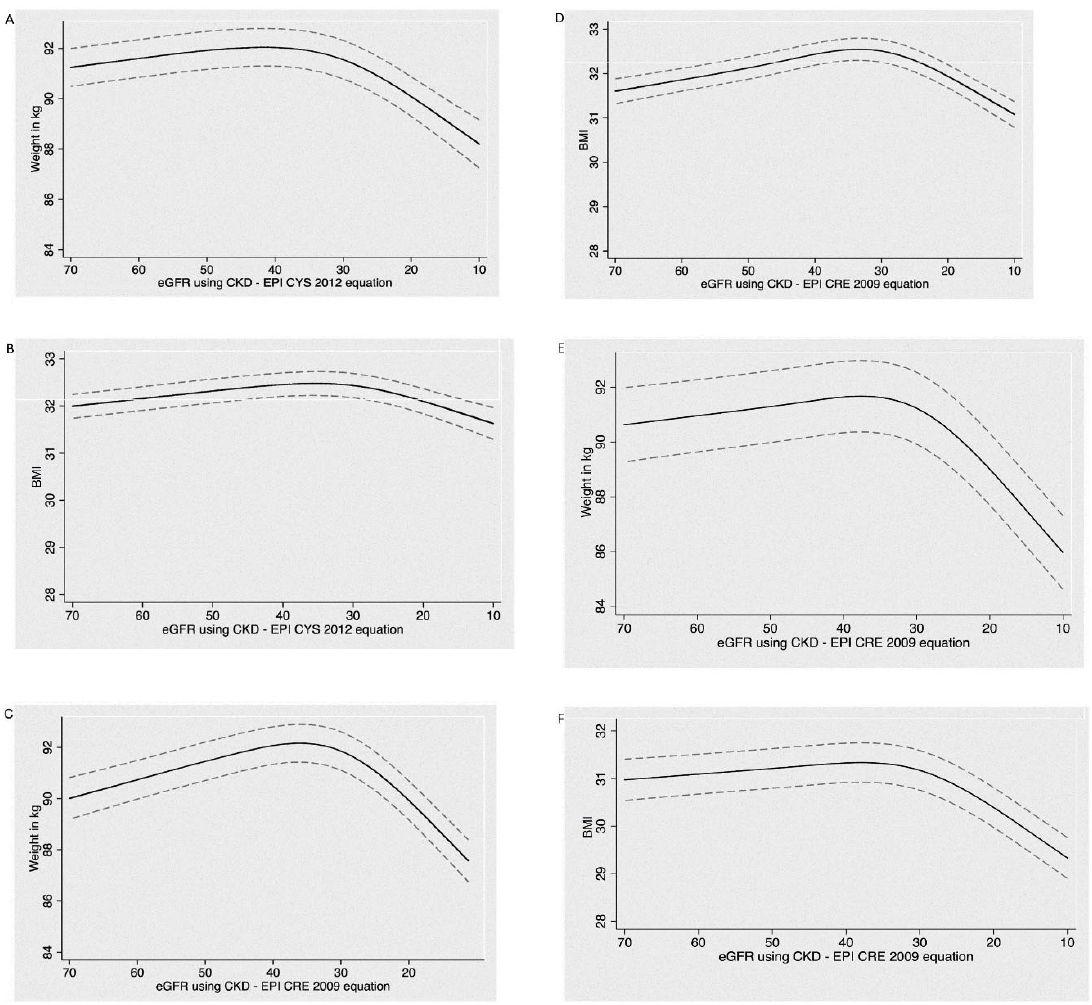
Figure 2. Repeated measures of weight and body mass index with advancing CKD. ( A ) Longitudinal repeated measures of weight with repeated measures of eGFR by cystatin C in CRIC. ( B ) Longitudinal repeated measures of BMI with repeated measures of eGFR by cystatin C in CRIC. ( C ) Longitudinal repeated measures of weight with repeated measures of eGFR by creatinine in CRIC. ( D ) Longitudinal repeated measures of BMI with repeated measures of eGFR by creatinine in CRIC. ( E ) Longitudinal repeated measures of weight with repeated measures of eGFR by creatinine in AASK. ( F ) Longitudinal repeated measures of BMI with repeated measures of eGFR by creatinine in AASK. Reprinted from Am J Kidney Dis., Vol. 71, Ku, E. et.al., Longitudinal Weight Change During CKD Progression and Its Association With Subsequent Mortality, Pages 657–665, Copyright (2018), with permission from the National Kidney Foundation, Inc [27] .